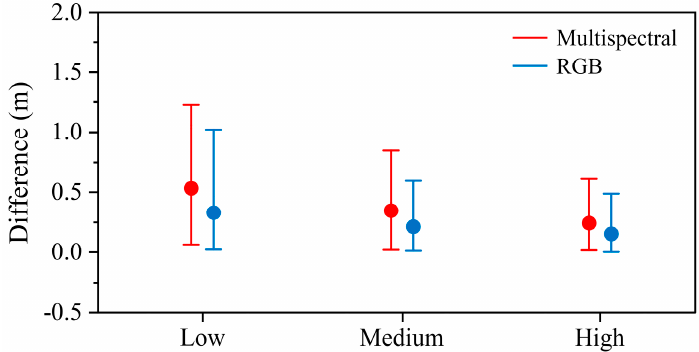
Figure 8. The differences between individual tree heights measured in the field and acquired in the DAP point cloud (including the multispectral point cloud and RGB point cloud) in three groups of sample plots.